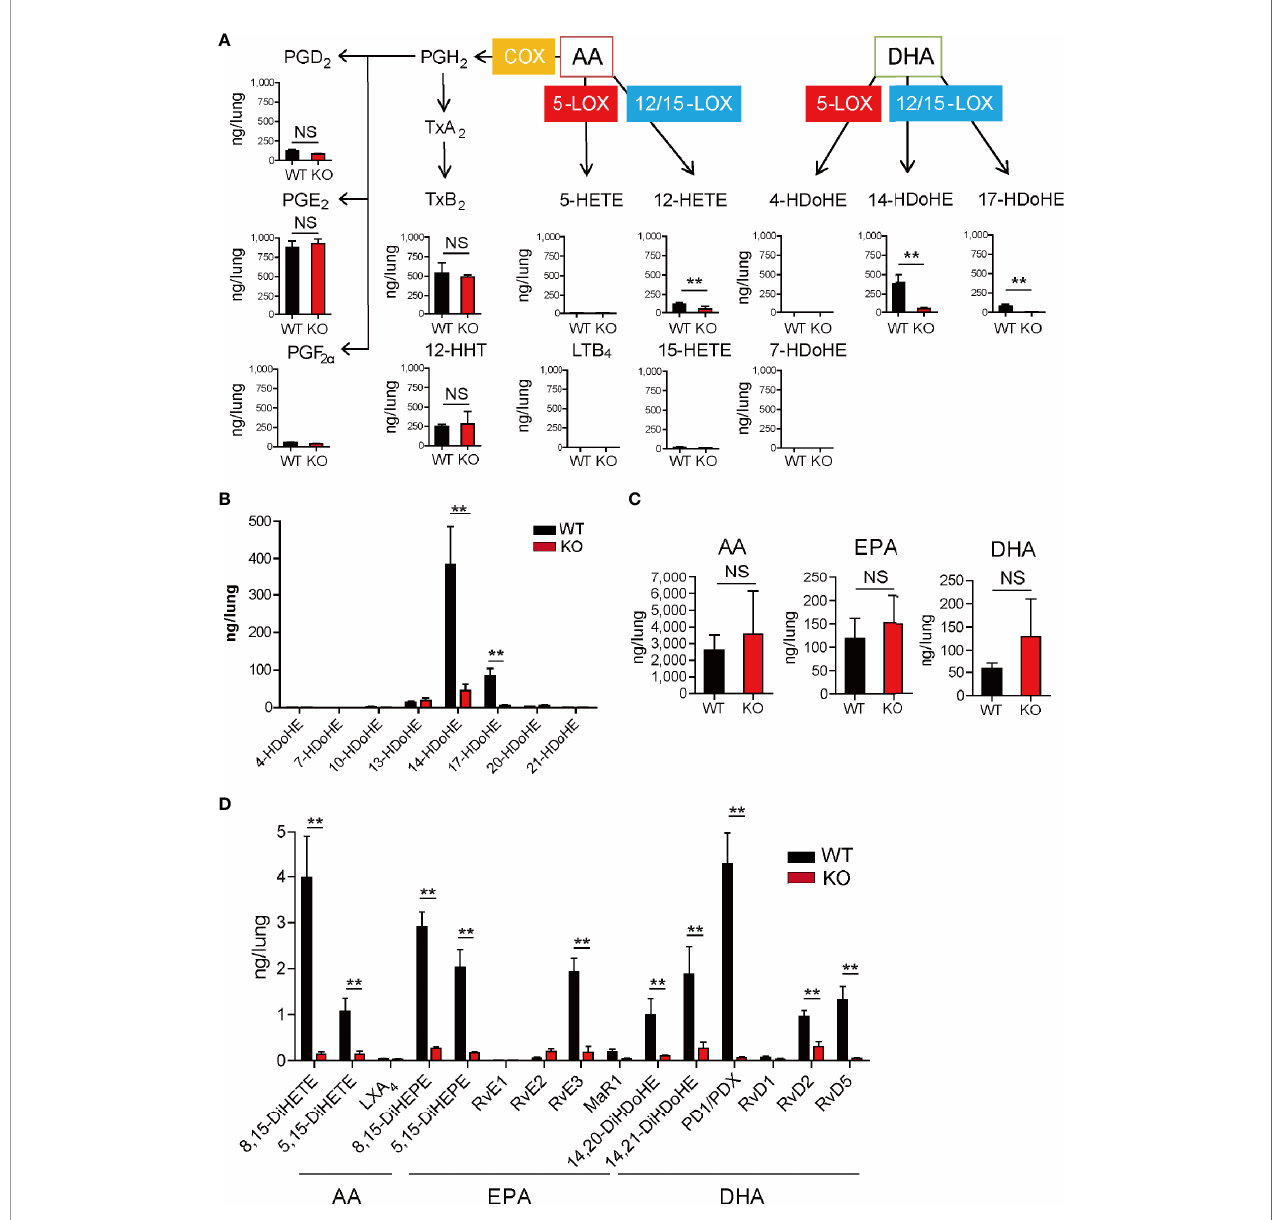
FIGURE 2 | Lipidomic pro fi les of lungs during IL-33-induced airway eosinophilic in fl ammation. Airway in fl ammation was induced by administration of IL-33 (500 ng per mouse, intranasal), for 3 consecutive days, in C57BL/6 and 12/15-lipoxygenase (LOX)-de fi cient mice. Analysis was performed 1 day after the fi nal administration of IL-33. (A) Lipidomic analysis showed quantitative alterations of arachidonic acid (AA) and docosahexaenoic acid (DHA)-derived metabolites via cyclooxygenase (COX), 5-LOX, and 12/15-LOX, including prostaglandins (PG), thromboxanes (Tx), 12- hydroxyheptadecatrienoic acid (HHT), hydroxyeicosatetraenoic acid (HETE), leukotriene B 4 (LTB 4 ), and hydroxy docosahexaenoic acid (HDoHE). (B) Comparative analysis of DHA-derived monohydroxy metabolites in wild-type or 12/15-LOX de fi cient mice. (C) Comparative analysis of the amounts of polyunsaturated fatty acids [AA, DHA, and eicosapentaenoic acid (EPA)] in wild-type or 12/15-LOX de fi cient mice. (D) Comparative analysis of 12/15-LOX-derived dihydroxy- or trihydroxy-lipid metabolites, including lipoxin (LX), Rv, MR, and protectin (PD). Mean ± SEM, n=3 for each group. **P < 0.01 (Student ’ s t-test). NS, not signi fi